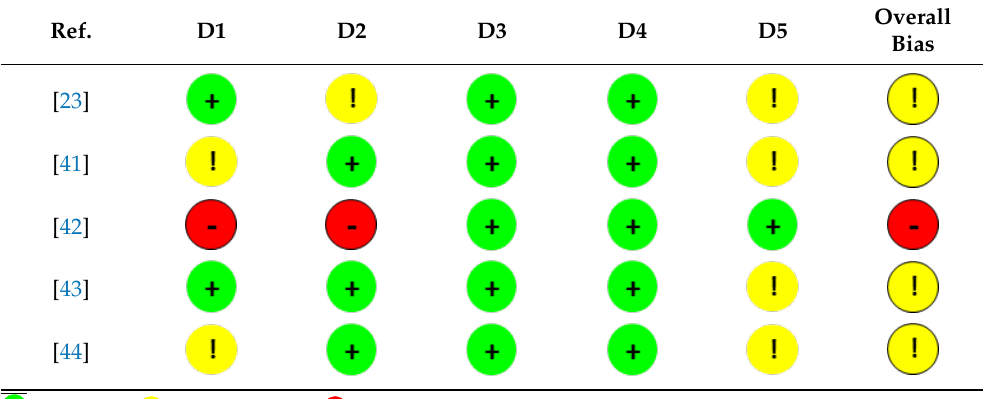
Table 5. Assessment of risk of bias, conducted based on revised Cochrane risk-of-bias tool for randomized trials, within randomized controlled trials included in this study. — high risk; risk of bias domains: D1 — arising from the ran- domization process; D2 — due to deviations from the intended interventions; D3 — due to missing outcome data; D4 — in measurement of the outcome; D5 — in selection of the reported result.